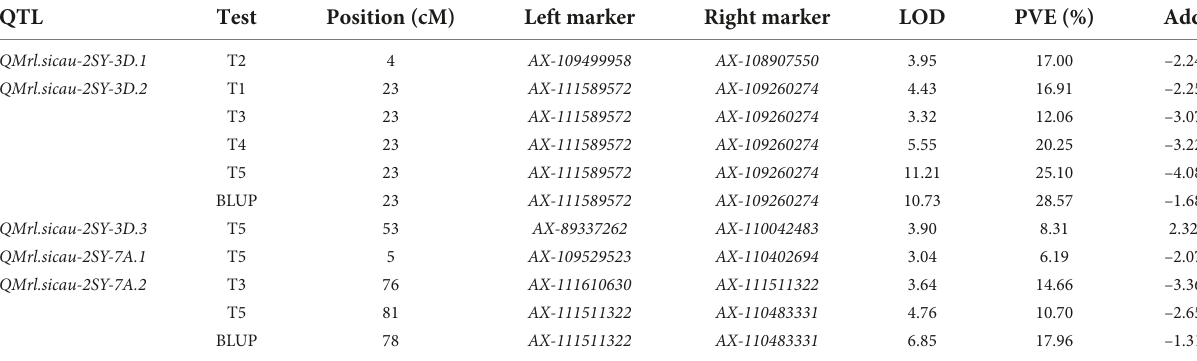
TABLE 4 Quantitative trait loci (QTL) for maximum root length (MRL) identified from five tests in the 20828/SY95-71(2SY) population. QTL Test Position (cM) Left marker Right marker LOD PVE